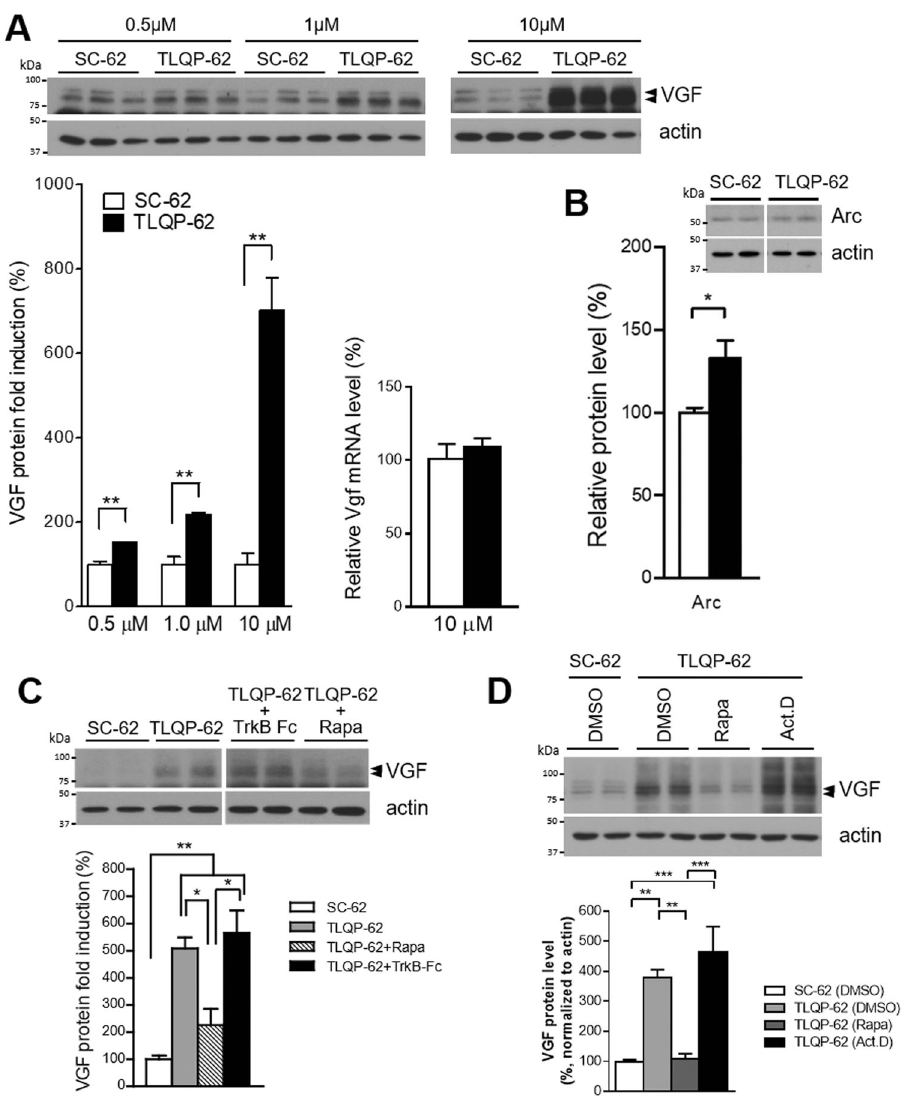
Fig. 2 Dose-dependent upregulation of VGF protein translation by the TLQP-62 peptide in cortical neurons depends on mTOR but not TrkB. A In primary cortical neurons, the level of the VGF protein was upregulated by TLQP-62 (0.5, 1, and 10 μ M) after 10 min of treatment compared with the SC-62 control. No induction of the Vgf mRNA was observed in TLQP-62 peptide-treated cortical neurons (10 μ M for 10 min). B Arc protein levels were upregulated in neurons treated with 10 μ M TLQP-62. The densitometry results of immunoblots in ( A , B ) are presented as the mean relative percentages ± s.e.m. and analyzed using Student t test. *, p < 0.05 and **, p < 0.01. C , D The selective increase in VGF protein translation stimulated by TLQP-62 peptide treatment depends on mTOR. C The induction of VGF protein expression by TLQP-62 (10 μ M for 10 min) was inhibited by the co-treatment of cortical neurons with rapamycin (Rapa, 20 ng/ml) but not TrkB-Fc (0.5 µg/ml). D Selective inhibition of mTOR by rapamycin (20 ng/ml) but not the transcriptional inhibitor actinomycin D (Act. D, 5 μ g/ml) abolished the TLQP-62-mediated increase in VGF protein levels in the hypothalamic cell line N38. Cells were pretreated with inhibitors, followed by co- treatment with the inhibitors and TLQP-62 (10 μ M) for 10 min. Densitometry results for immunoblots are shown as the mean relative percentages ± s.e.m. and were analyzed using one-way ANOVA with Tukey ’ s post hoc analysis. *, p < 0.05; **, p < 0.01 and ***, p < levels (1.84-fold) compared with wild-type neurons, while Vgf Vgf 3 ′ UTR truncation results in the upregulation of neuronal mRNA levels remained unchanged (Fig. 4A). Moreover, when VGF and other granin proteins examining the brain tissues collected from adult Vgf 3 ′ UTR- We previously generated a Vgf 3 ′ UTR-truncated mouse model truncated mice ( Vgf Δ / Δ ), we observed speci fi c increases in the ( Vgf Δ / Δ ), in which an inverted neomycin selection cassette was inserted into the Vgf 3 ′ UTR, creating a noncanonical polyade- levels of the VGF, CgB and Scg2 proteins but not mRNA levels in nylation signal (Supplemental Fig. 3A) and resulting in partial the dorsal hippocampus compared with their wild-type litter- truncation of the Vgf mRNA 3 ′ UTR (full-length form: 1 – 512 bp of mate controls (Fig. 4B, C). The levels of other granin proteins, Vgf 3 ′ UTR; truncated form: 1 – 202 bp of Vgf 3 ′ UTR plus partial including CgA and Scg3, remained unchanged or showed a sequence of the inverted neomycin selection cassette) (Supple- trend toward a decrease in the dorsal hippocampus of adult Vgf mental Fig. 3B). Interestingly, primary hippocampal neurons 3 ′ UTR-truncated mice. These results con fi rmed the effect of the (21 DIV) isolated from homozygous Vgf 3 ′ UTR-truncated mouse Vgf 3 ′ UTR on repressing the neuronal expression of VGF and embryos ( Vgf Δ / Δ ) showed increased VGF protein expression other granin proteins in vivo.